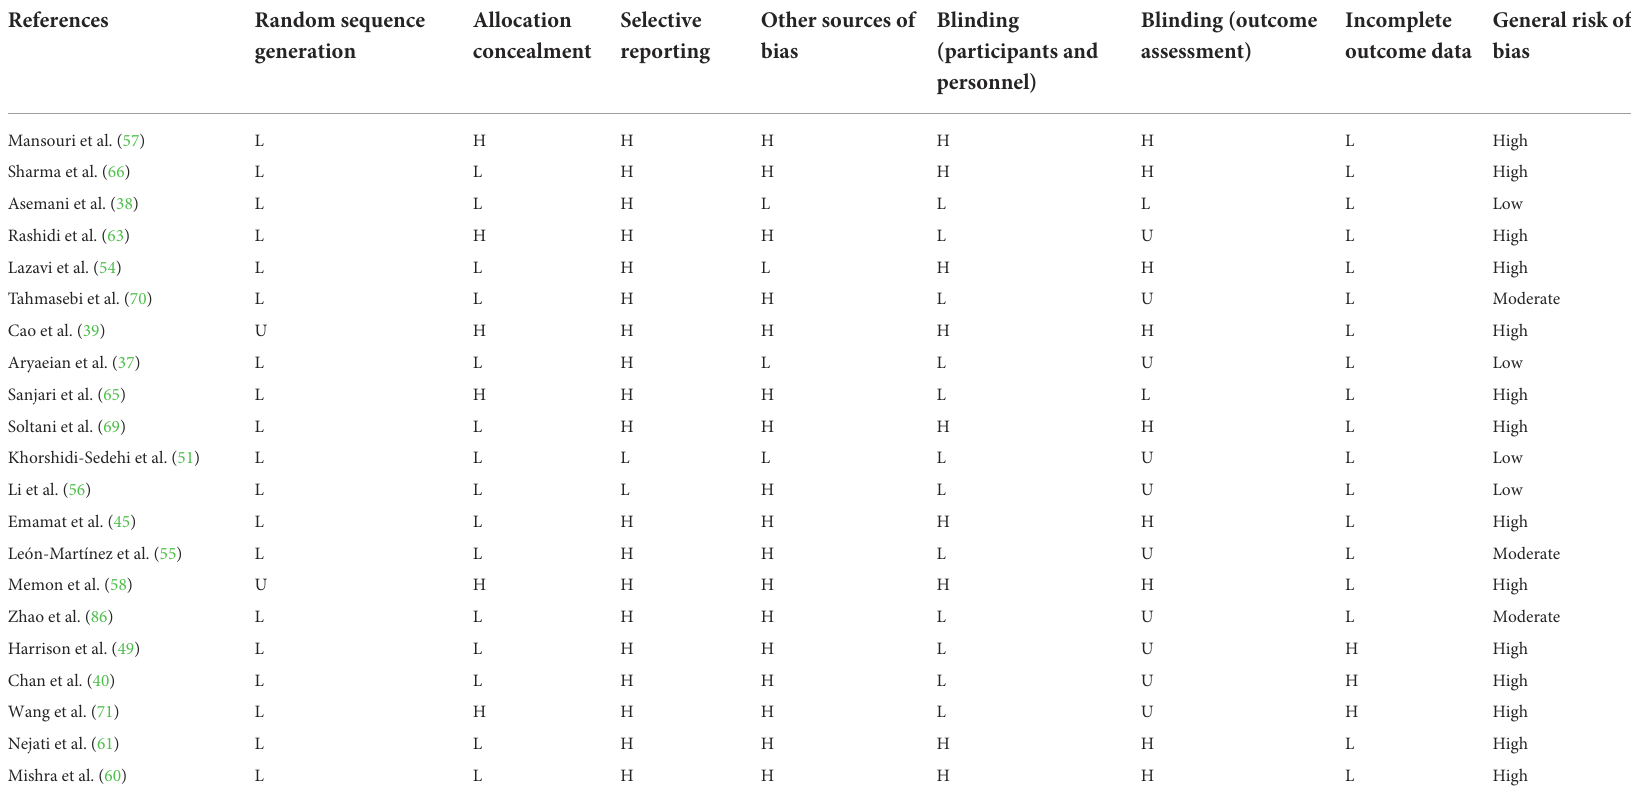
L H H H H L High Mishra et al. (60) L L H H H H L High Generallowrisk < 2highrisk. Generalmoderaterisk 2highrisk. = Generalhighrisk >